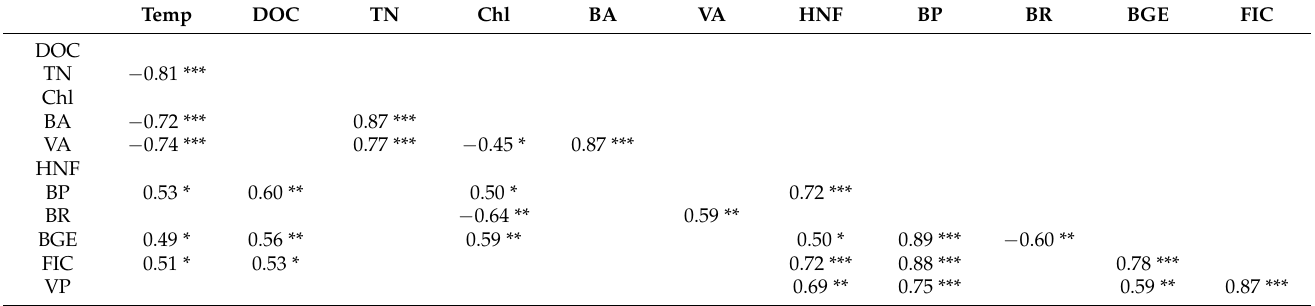
Table 4. Pearson correlation coefficient values among different environmental variables ( n =